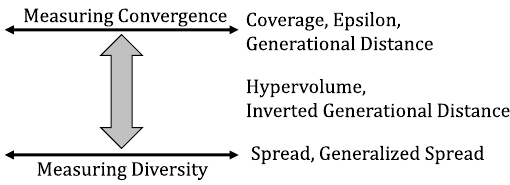
Figure 5. Taxonomy of multi-objective performance